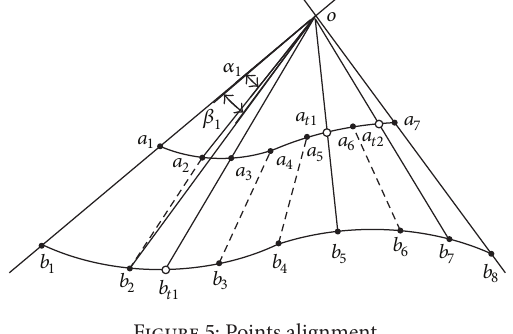
Figure 5: Points